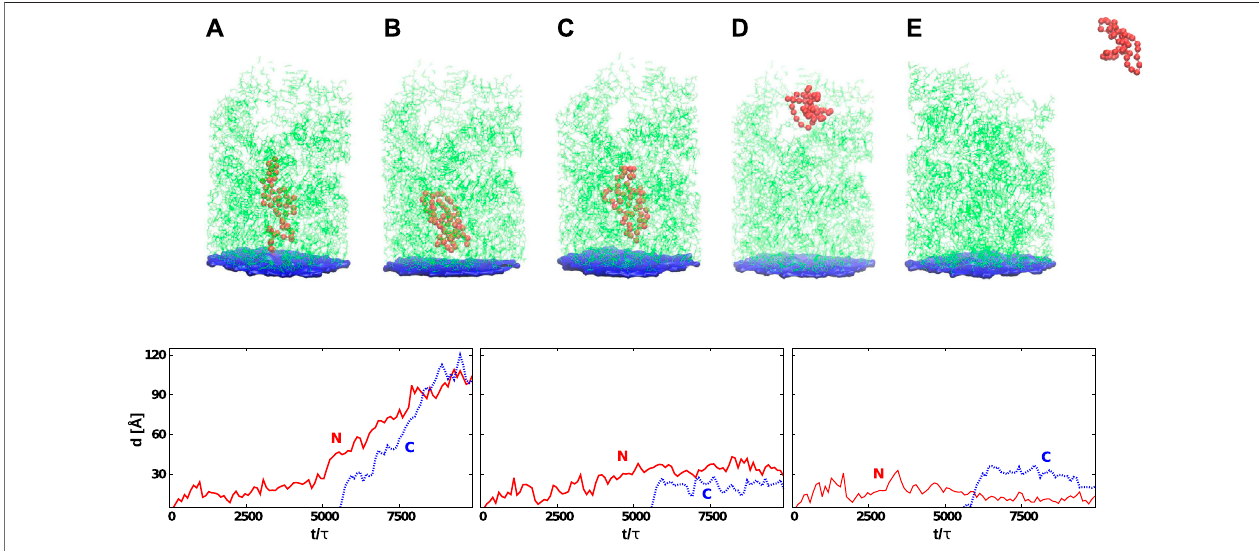
FIGURE 6 | Top: Six snapshots of protein G (the red color) at various stages of its development that start at its synthesis (A) and, in many cases, end with the detachment (E) . The averagetime needed bythe ribosome to release theprotein depends on t w .The exit tunnel (in green) corresponds tothe eukaryotic structure PDB: 6EK0. The blue plane represents the origin of the repulsive potential. The PTC is located at the center of the plane. In (B) , the protein is stuck permanently at the CS1. In (C) , the jamming is at CS2. In (D) , the protein has reached the mouth of the tunnel. Bottom: Distances between the PTC and the N-terminus (solid-red line) or C-terminus (dotted-blue line) as a function of time. The left panel corresponds to the situation presented in (D) (protein is leaving the ribosome). The graph in the center correspondstothesituationshown in (C) (theproteingets stuckatCS2).Thelastgraphshowsthesituation correspondingto (B) (theproteinisstuckbetweenPTCand CS1). In all cases, the C-terminus gets released after the synthesis of the 56-residue protein which, for t w (cid:1) 100 τ , corresponds to 5,600 τ